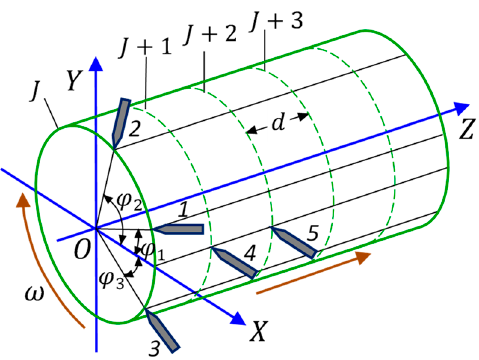
Figure 3. Schematic of parallel scan EST for measurement of cylindrical profile. The 1–5 are the displacement probes.